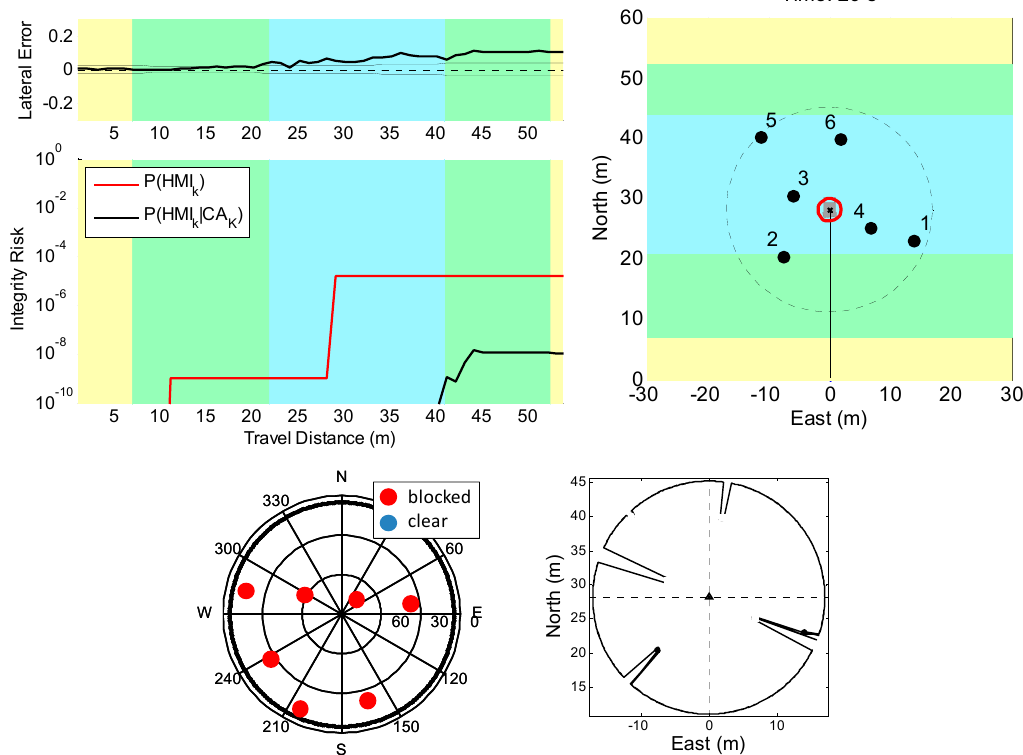
Figure 2. Simulation results assuming no unwanted objects (UO). ( top left ) On the upper plot, the thick black line represents the actual cross-track positioning error and the thin line is the one-sigma covariance envelope. The lower plot shows P ( HI k ) bounds for the GPS-denied area crossing scenario. ( top right ) Snapshot vehicle-landmark geometry at the time step corresponding to the large increase in P ( HI k ) Bound (time = 29 s). ( bottom left ) Azimuth elevation sky plot showing GPS satellite geometry at time = 29 s. ( bottom right ) Snapshot LiDAR scan at time = 29 s when landmark “1” is hidden behind landmark